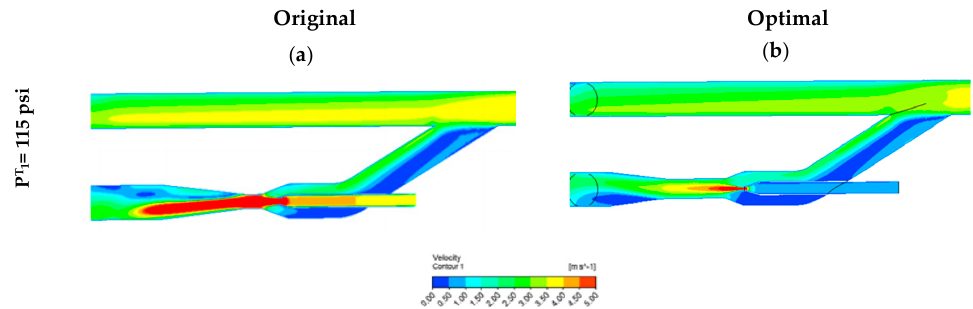
Figure 16. Velocity contours for original seed pump ( a ) and optimized one ( b ) @ 115 psi.